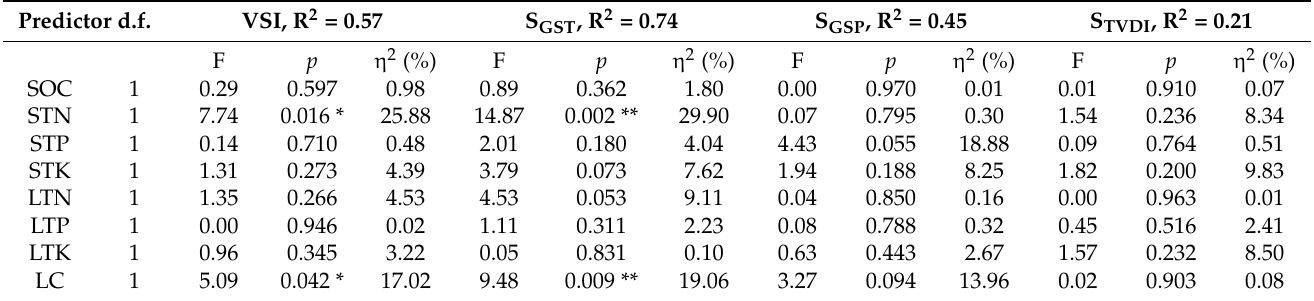
Table 3. Main effects of soil nutrient availability and plant nutrient traits on vegetation sensitivity index (VSI) of desert scrubs across the Qaidam Basin. Abbreviations were the same as in Table 1. d.f., the degree of freedom; F, variance ratio; p , significance level; η 2 , Eta squared, the percentage of sum squares explained. The difference significant at the 0.01 and 0.05 levels were labeled with ** and *, respectively.